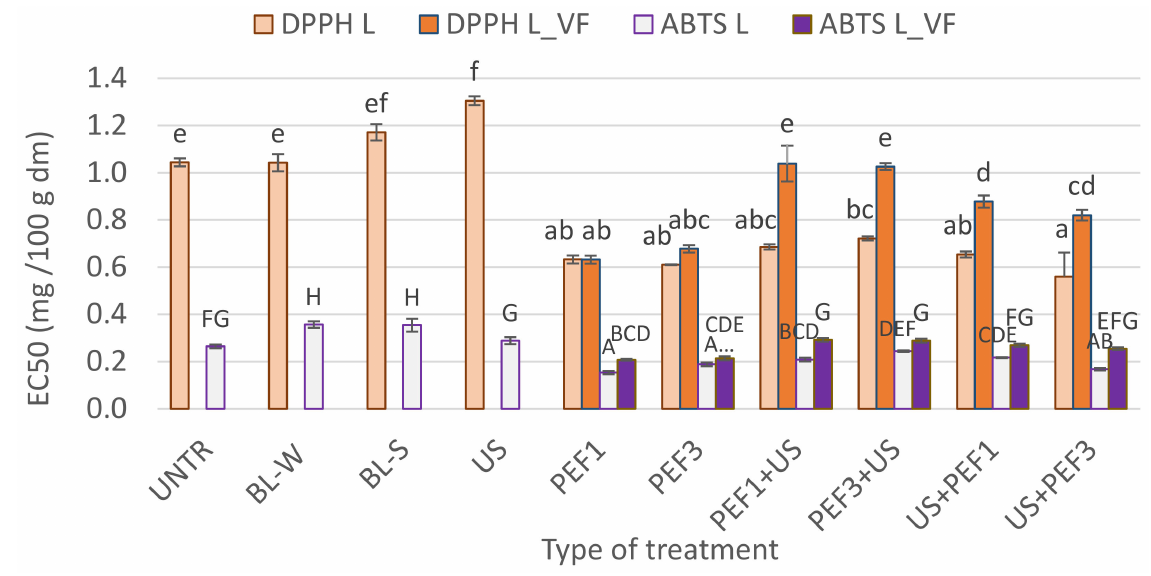
Figure 6. Antioxidant activity expressed as EC50 (the effective concentration of the sample, which can decrease the concentration of 1,1-diphenyl-2-picrylhydrazyl radical—DPPH • or 2,2-azinobis (3-ethylbenzothiazoline-6-sulfonate) radical cation—ABTS • + by 50%) of lyophilized red bell peppers treaded with traditional treatment (BL_W—blanching in water, BL_S—steam blanching), novel single treatment (US—sonication for 30 min, PEF_1—pulsed electric field with energy input 1 kJ/kg, PEF_3—pulsed electric field with energy input 3 kJ/kg) or novel hybrid treatment (PEF+US, US+PEF), preceded by shock freezing (L) and vacuum freezing (L_VF). Data are presented as a mean from 3 repetitions with error bars as a standard deviation (SD), data with different letters lowercase and uppercase differ significantly for L and L_VF, respectively (Tukey’s HSD, p <